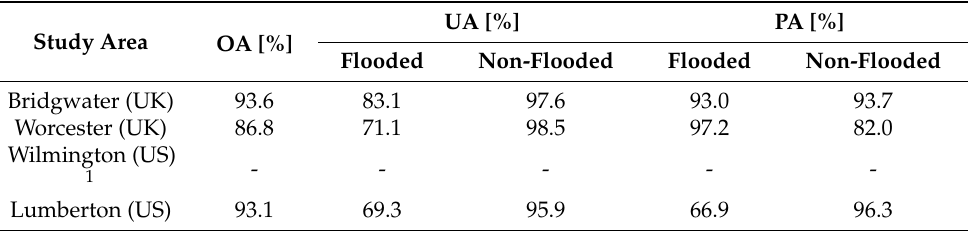
Table 3. Overall Accuracy (OA), User Accuracy (UA), and Producer Accuracy (PA) of the flood delineation maps for each study